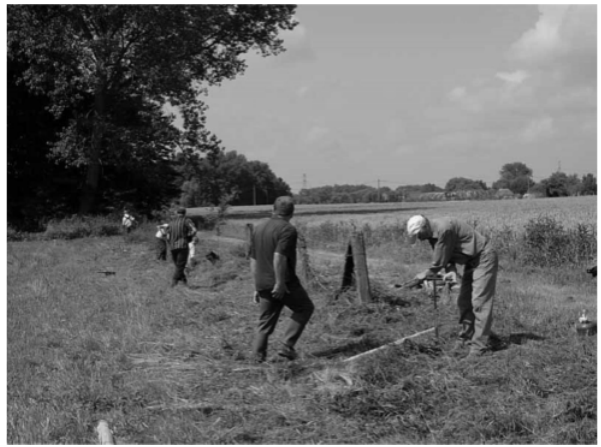
Figure 2. Natuurpunt Zemst [Untitled Photograph] From Wissels: Handboek sociaal- cultureel werken met volwassenen (p. 493), by F. Cockx, H. De Blende, G. Gehre, G. Van den Eeckhaut and G. Verschelden (Eds.), 2011, Brussels: SoCiuS. Permission to use the picture from Natuurpunt